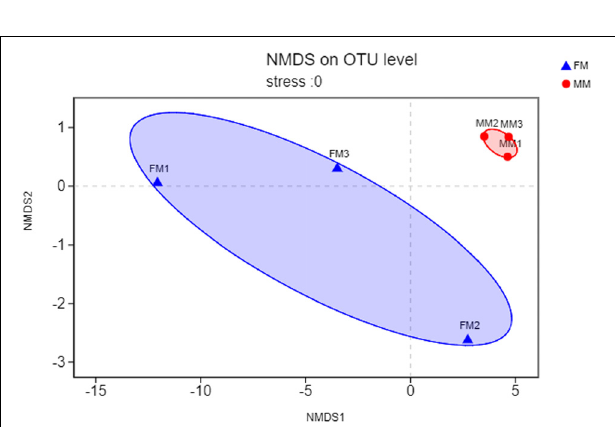
FIGURE 4 | Clustering tree constructed by UPGMA (FM, female swamp eel; MM, male swamp eel). Difference in Microbial Composition in Female Versus Male Swamp